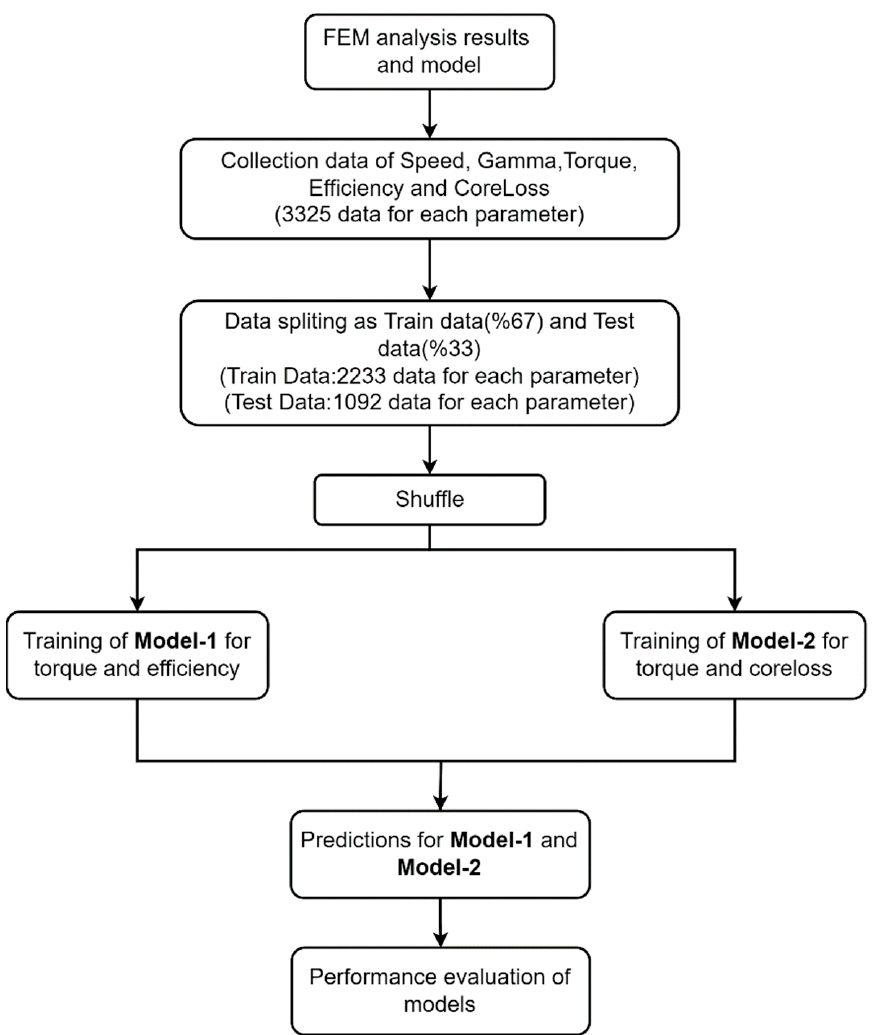
Figure 5. Proposed method flowchart.